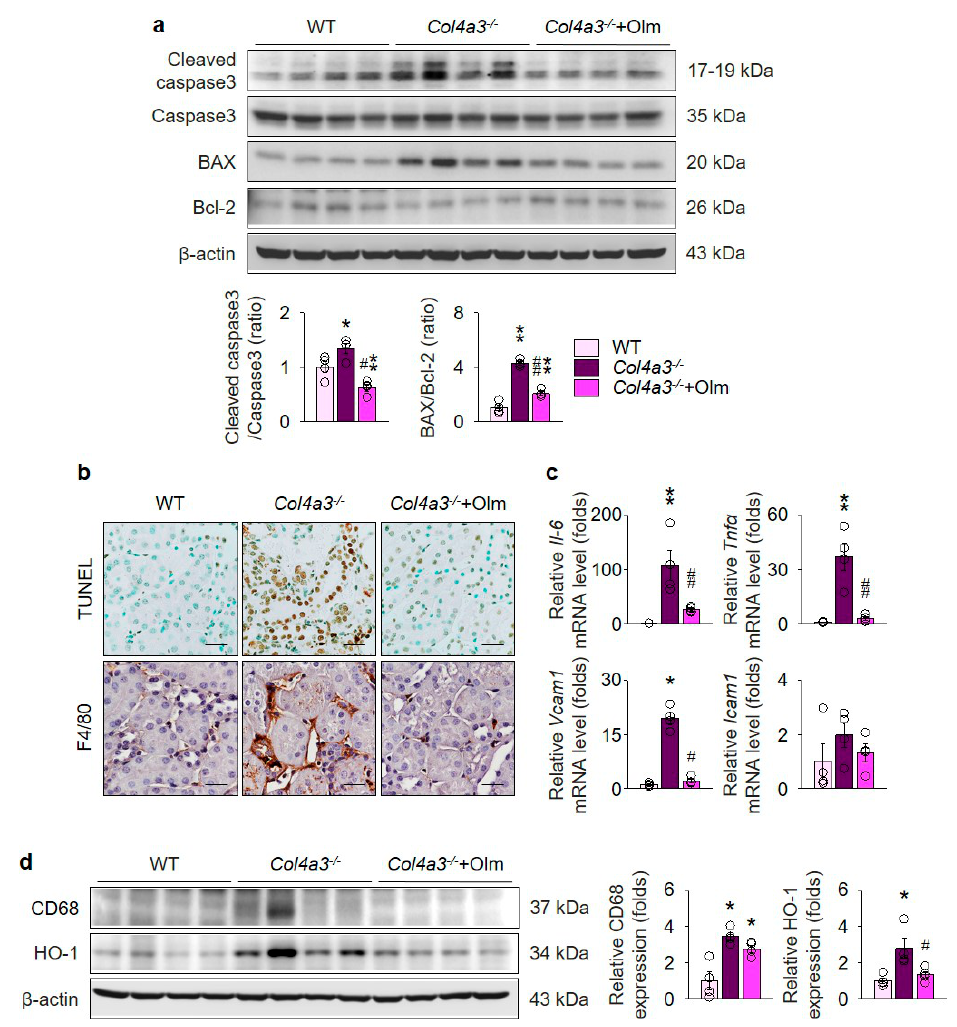
Figure 5. Olmesartan suppresses apoptosis and inflammation in the kidney of Col4a3 –/– mice. ( a ) 2 Comparison of protein expression level for molecules related to apoptosis determined by 3 immunoblotting from the kidney of WT, Col4a3 –/– , and Col4a3 -/- +Olm mice ( n = 4 mice/group). β -actin 4 was used as the endogenous control. ( b ) Representative images of TUNEL (upper) and 5 immunohistochemical staining for F4/80 (lower) in the kidney of WT, Col4a3 –/– , and Col4a3 -/- +Olm 6 mice. ( c ) Comparison of mRNA expression level for inflammatory markers determined by qPRC from 7 the kidney of WT, Col4a3 –/– , and Col4a3 -/- +Olm mice ( n = 4 mice/group). β -actin was used as the 8 endogenous control. ( d ) Comparison of protein expression level for CD68 and hemoxygenase-1 (HO- 9